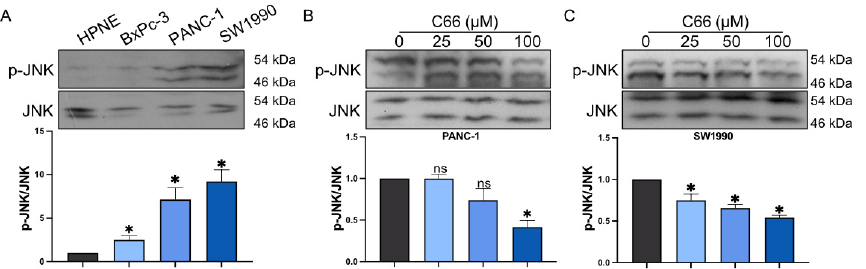
Figure 5. Reduction in pancreatic cancer cell JNK activation by C66 targeting. ( A ) JNK activation in HPNE, BxPC-3, PANC-1, and SW1990. ( B , C ) JNK activation measured in PANC-1 and SW1990 cells